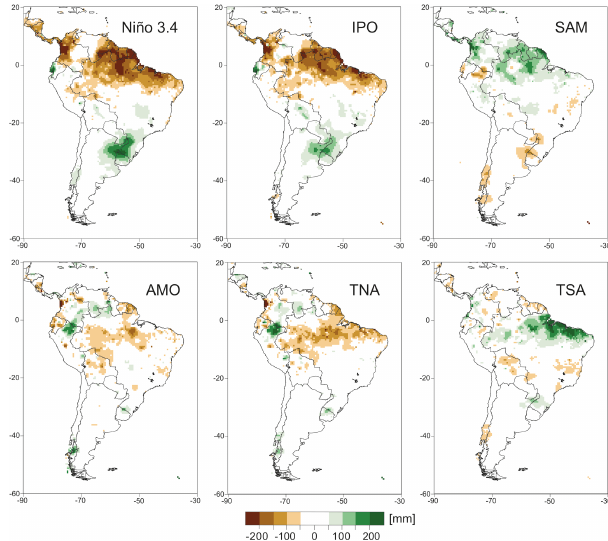
Figure 4. Precipitation correlation with modes Niño3.4, IPO (Inter- decadal Pacific Oscillation), SAM (Southern Annular Mode), AMO (Atlantic Multidecadal Oscillation), TNA (tropical North Atlantic SST), and TSA (tropical South Atlantic SST). High positive values of the correlation coefficient indicate both increasing and decreas- ing values of the mode in question and the local precipitation at each grid cell. High negative values indicate that the increasing (de- creasing) mode in question causes a significant decrease (increase) in precipitation at the grid cell.